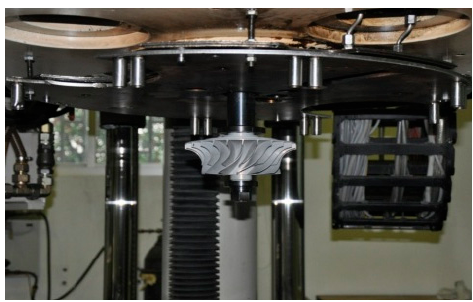
Figure 22. Structure strength test equipment.